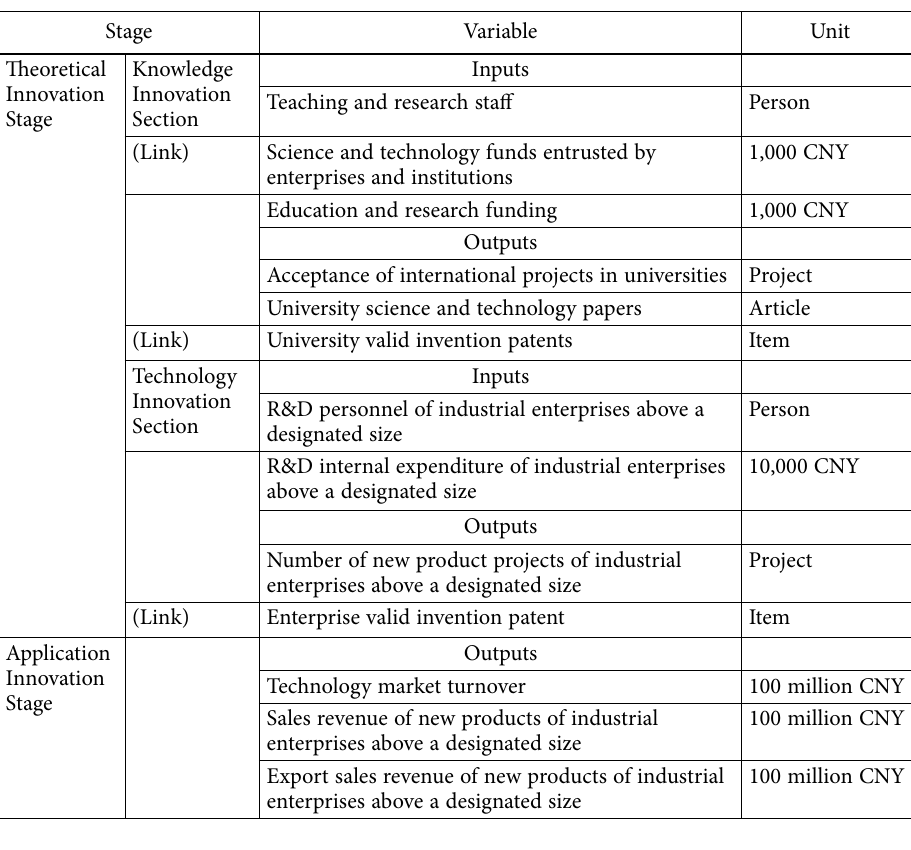
Table 1. Input and output variables